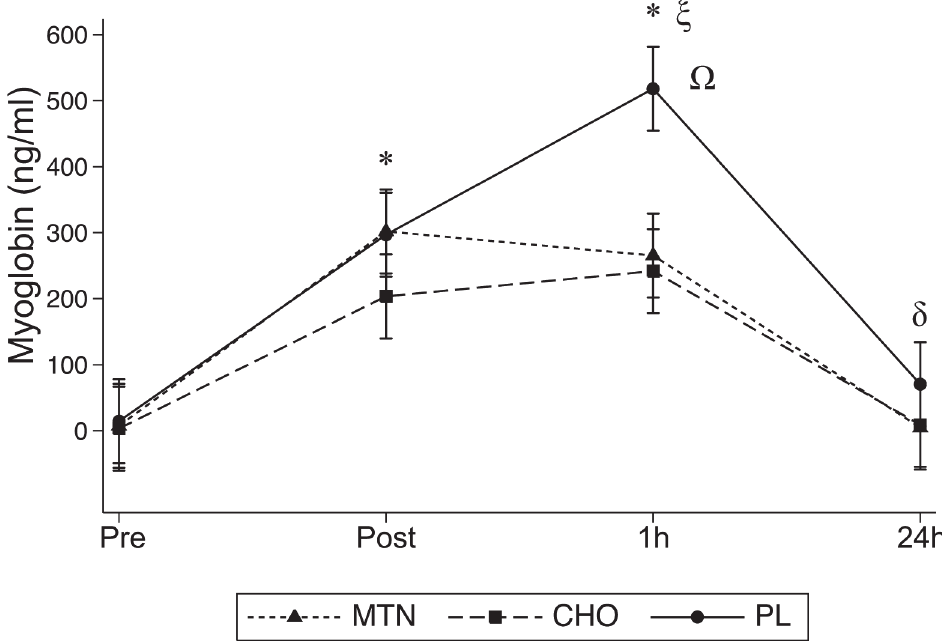
Fig 3. Serum Mb concentrations determined at all times points for the three conditions. * p < 0.05 compared to pre for the three conditions; ξ p < 0.01 from 1h to immediately after (post) only for placebo condition; δ p < 0.01 compared to immediately after (post) for MTN and CHO; Ω p < 0.05 at both 1hr and 24h post exercise from MTN and CHO to placebo.